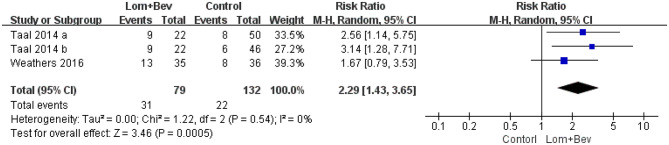
Forest plot of 6-month PFS in glioblastoma between lomustine plus bevacizumab and control groups. Six-month PFS, the percentage of patients who could progression-free survival for 6 months; Lom, lomustine; Bev, bevacizumab.